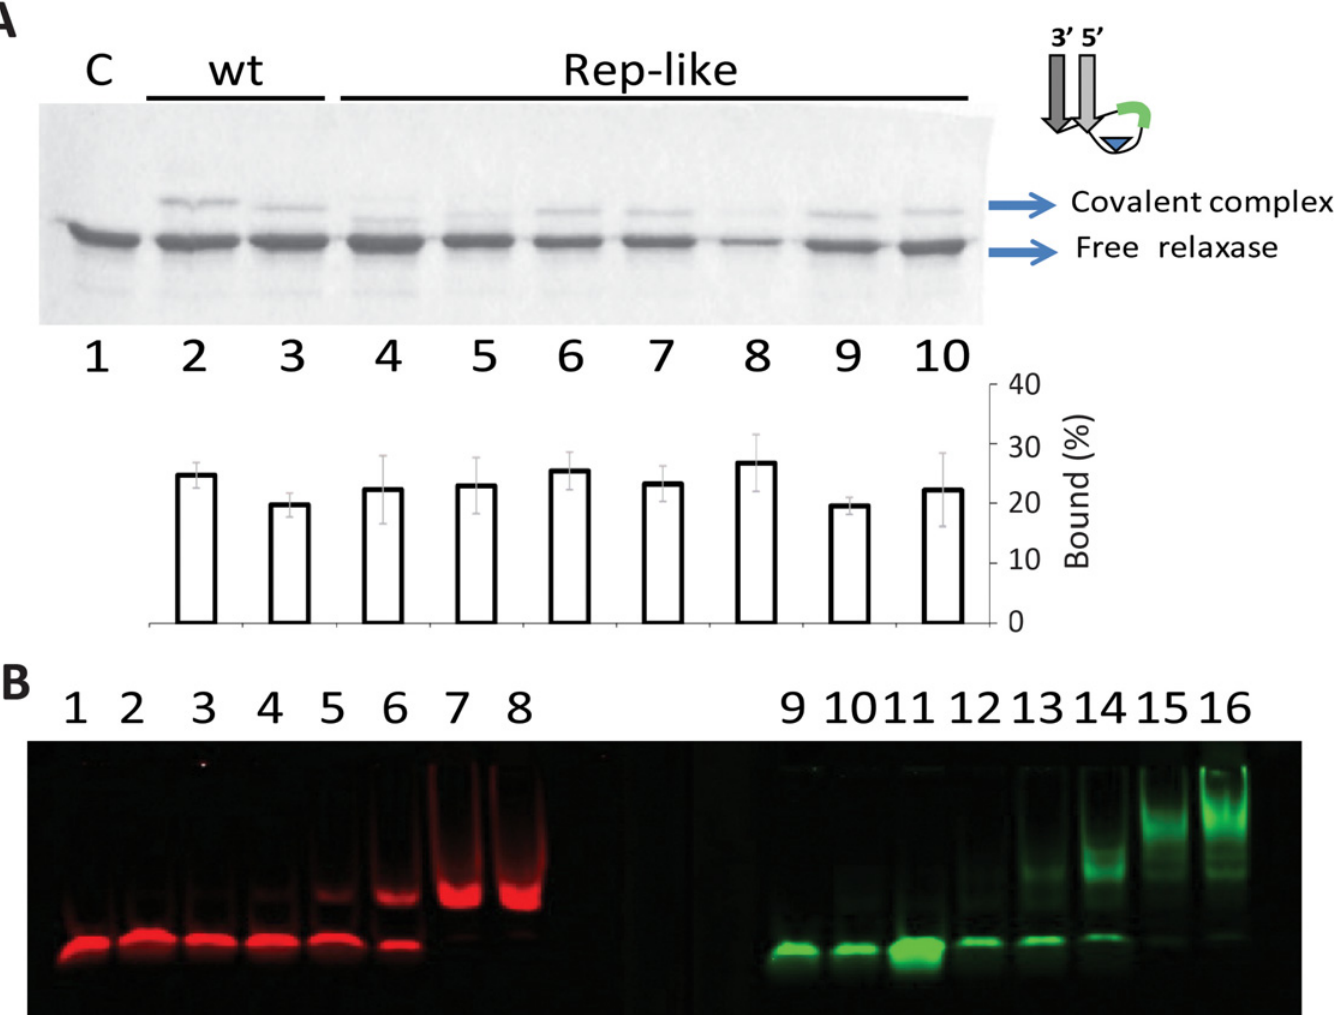
Fig 2. Interaction of TrwC R with Rep-like substrates. (A) SDS-PAGE of oligonucleotides with R388wt or Rep-Like structures, when incubated with TrwC R . 6 μ M TrwC R was incubated with 15 μ M of different oligonucleotides. The reaction products were separated by electrophoresis in 12% SDS-PAGE gels. Lane 1, no oligonucleotide; Lanes 2 and 3, R388wt oligonucleotides W(25+18) and W(14+14), respectively; in subsequent lanes, TrwC R was incubated with Rep- like oligonucleotides. The S length of Rep-like substrates (in green), varies from two to eleven nucleotides. Lane 4, H(14+8), Lane 5, H(14+10), Lane 6, H(14 +12); Lane 7, H(14+13), Lane 8, H(14+14); Lane 9, H(14+15); Lane 10, H(14+17). In the center chart, percentage of bound complexes were calculated in three separate experiments such as that shown in (A). (B) Increasing amounts of TrwC R were incubated with wt oligonucleotide W(25+8) (red shift, lanes 1 to 8) or Rep-like hairpin H(14+14) (green shift, lanes 9 – 16). Lanes 1 and 9, no protein added; 2 and 10, 42 nM of TrwC R ; 3 and 11, 85 nM; 4 and 12, 210 nM; 5 and 13, 420 nM; 6 and 14,850 nM; 7 and 15, 4,2 μ M, 8 and 16, 8,5 μ